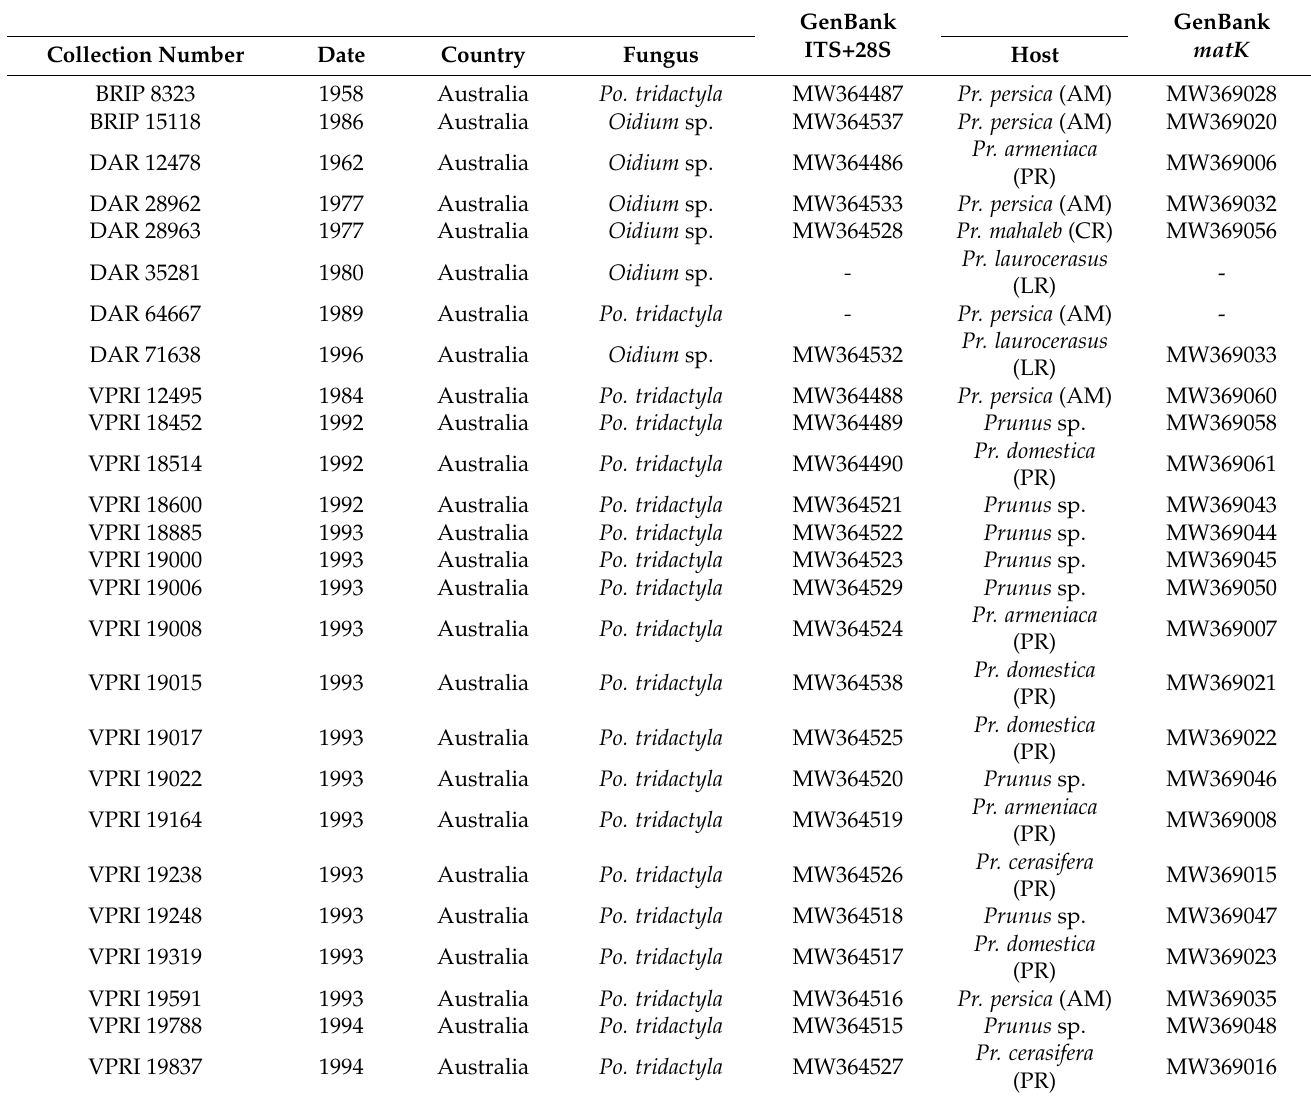
Table 1. Collection details for the 58 powdery mildew collections on Prunus used in this study with fungus and plant host species as listed with collection and GenBank accession numbers. For hosts, abbreviations in brackets refer to divisions within Prunus : AM: subgenus Prunus section Amygdalus , CR: subgenus Cerasus , LR: subgenus Padus section Laurocerasus , PD: subgenus Padus section Padus and PR: subgenus Prunus section Prunus . Po . = Podosphaera , Pr . = Prunus